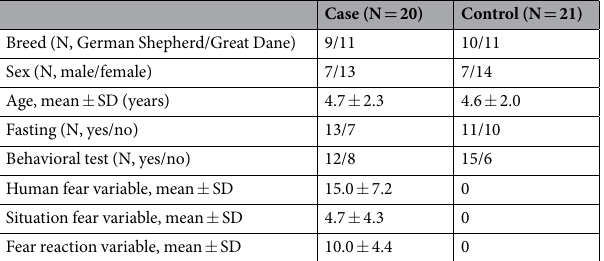
Table 1. Demographic and behavioural characteristics of study participants. SD = standard